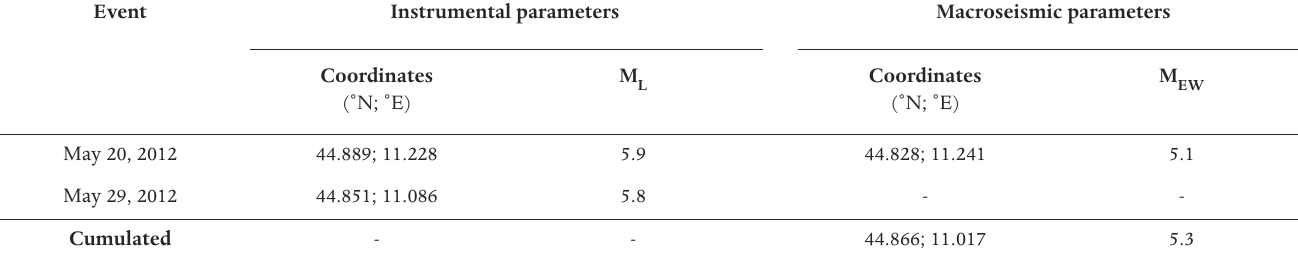
Table 2. Instrumental parameters [ISIDe 2010] of the May 20 and 29, 2012, earthquakes, and the macroseismic parameters based on the May 20, 2012, intensities and the cumulative intensities computed by Boxer 4.0 [Gasperini et al.